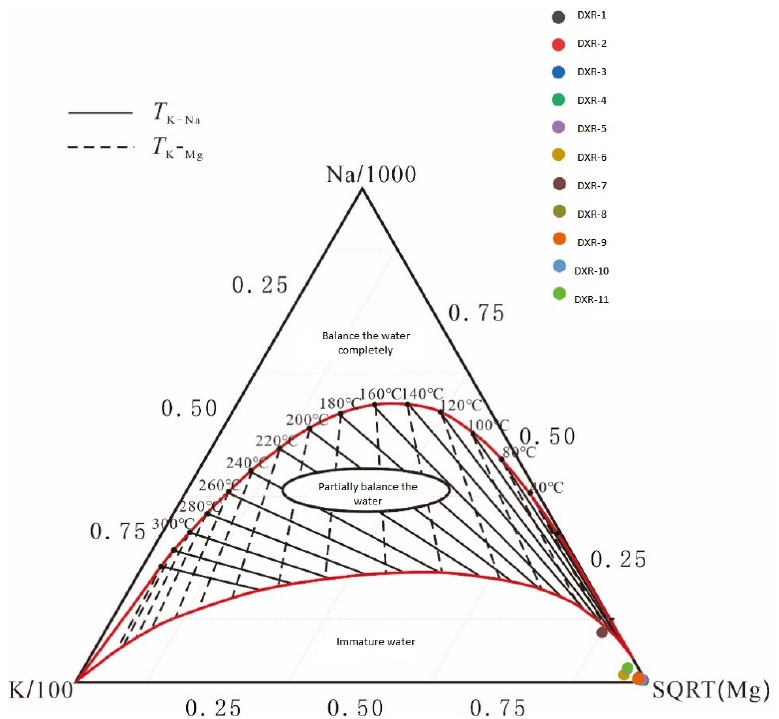
Figure 4. Na-K-Mg triangle diagrams of the geothermal fluid in the study area.